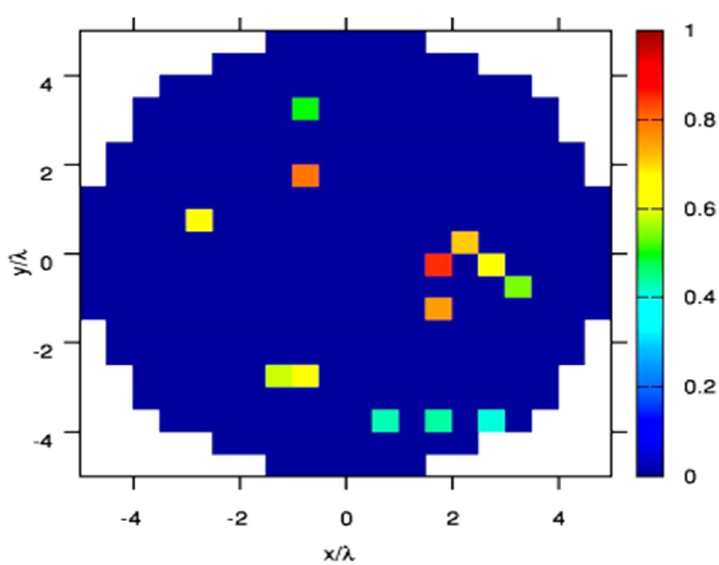
Figure 4. Normalized array excitation of the array under test (AUT).